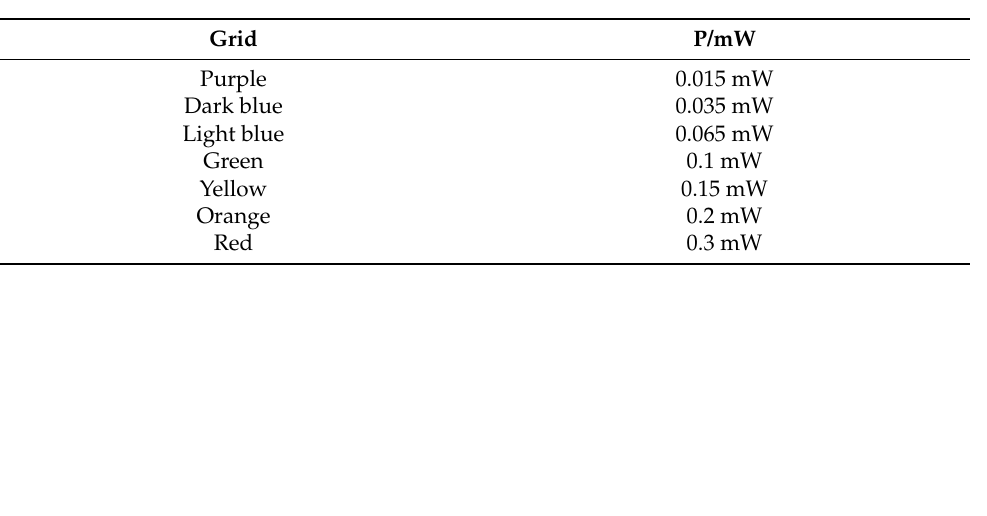
Table 5. Specific transmission power